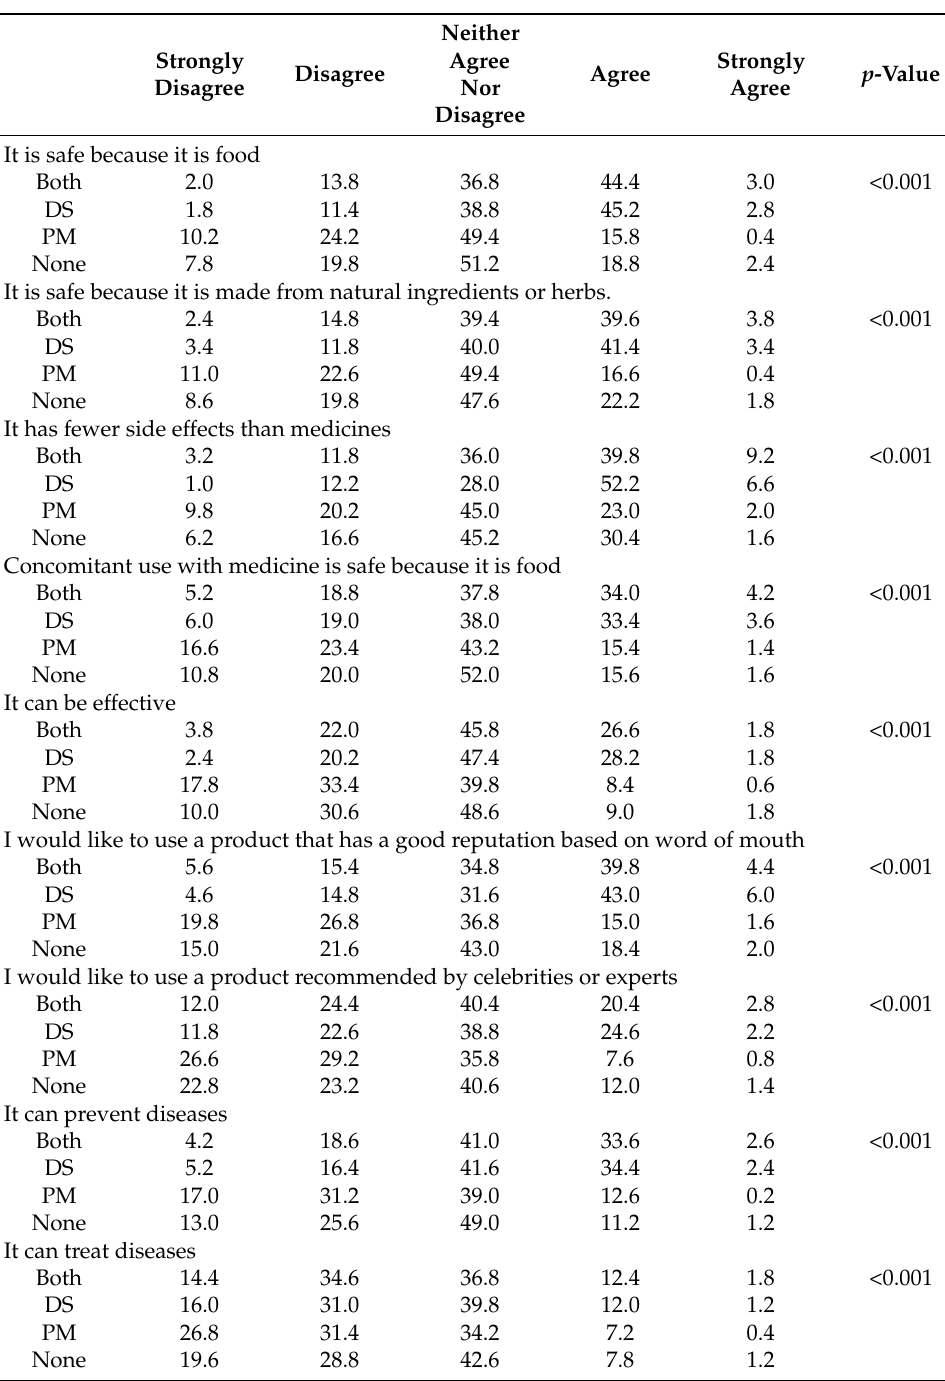
Table 8. Perception of dietary